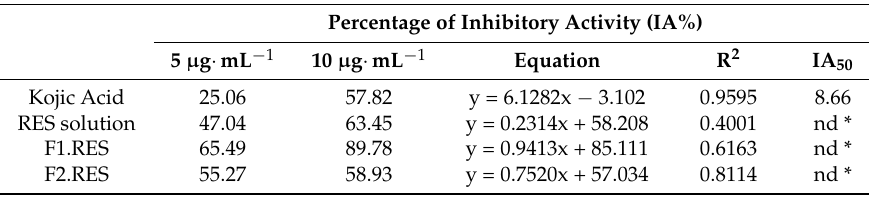
Table 4. Tyrosinase inhibitory activity of RES and RES-loaded SLNs.